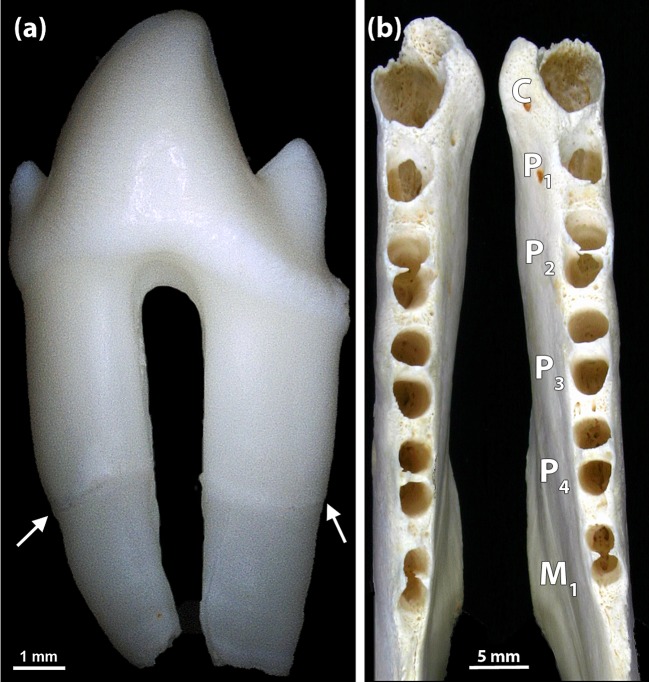
Simplified crown shape and elongated tooth roots in a 2-week-old male Eastern Atlantic harbor seal (Phoca vitulina vitulina, specimen ZIK 27251).(a) Premolar with simplified (tricuspid) crown and elongated roots. Arrows: periradicular bands. (b) Dorsal view of the mandibles, with identification of the alveoli for the canine, the premolars and the M1. Note abnormally wide interdental septa.